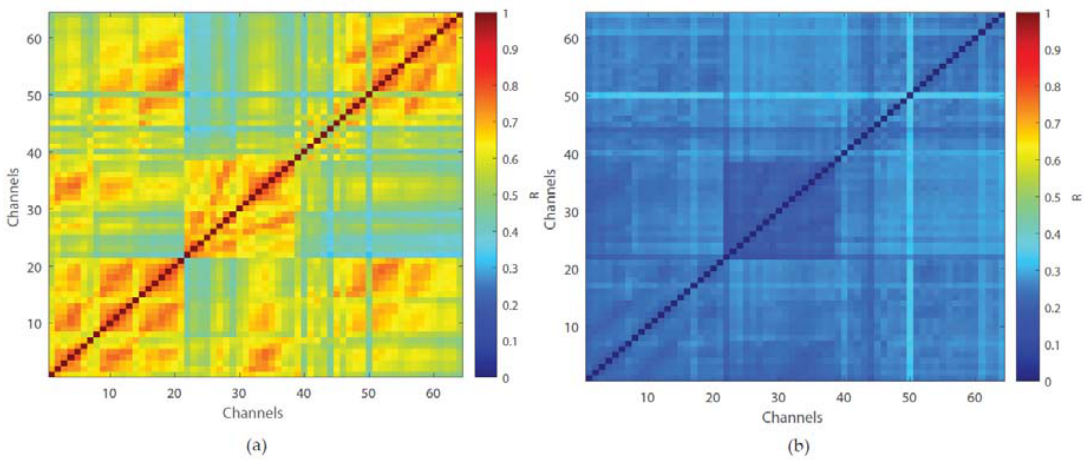
Figure 2. Mean cross-correlation of all features ( a ) and standard deviation of the mean ( b ).